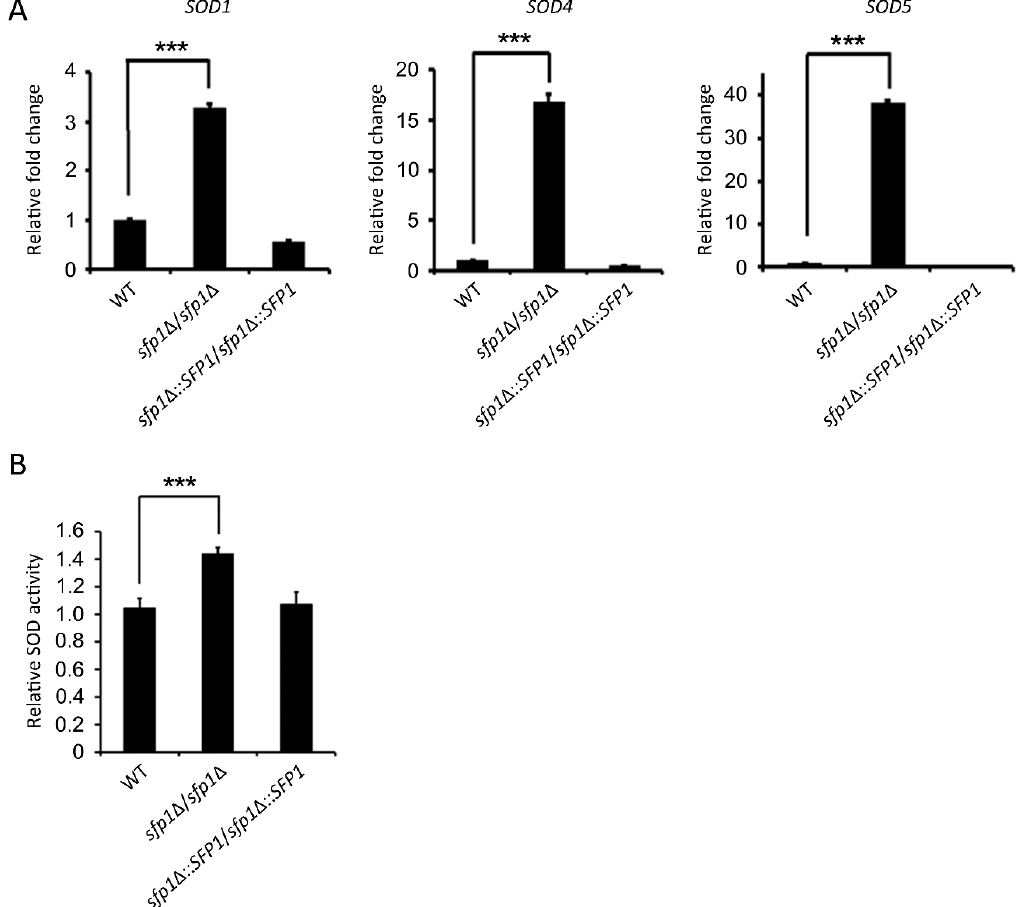
Figure 3. SOD gene expression and activity in cells treated with menadione. ( A ) The expressions levels of SODs were analyzed using real-time qPCR after treatment of the cells with 170 µ M menadione for 2 h. The PMA1 transcript was used as an endogenous control. ( B ) Cells were treated with 170 µ M menadione for 2 h, and Sod enzyme activity was then measured. The results are presented as the mean ± standard deviation (SD) of three independent experiments. *** P < 0.001.